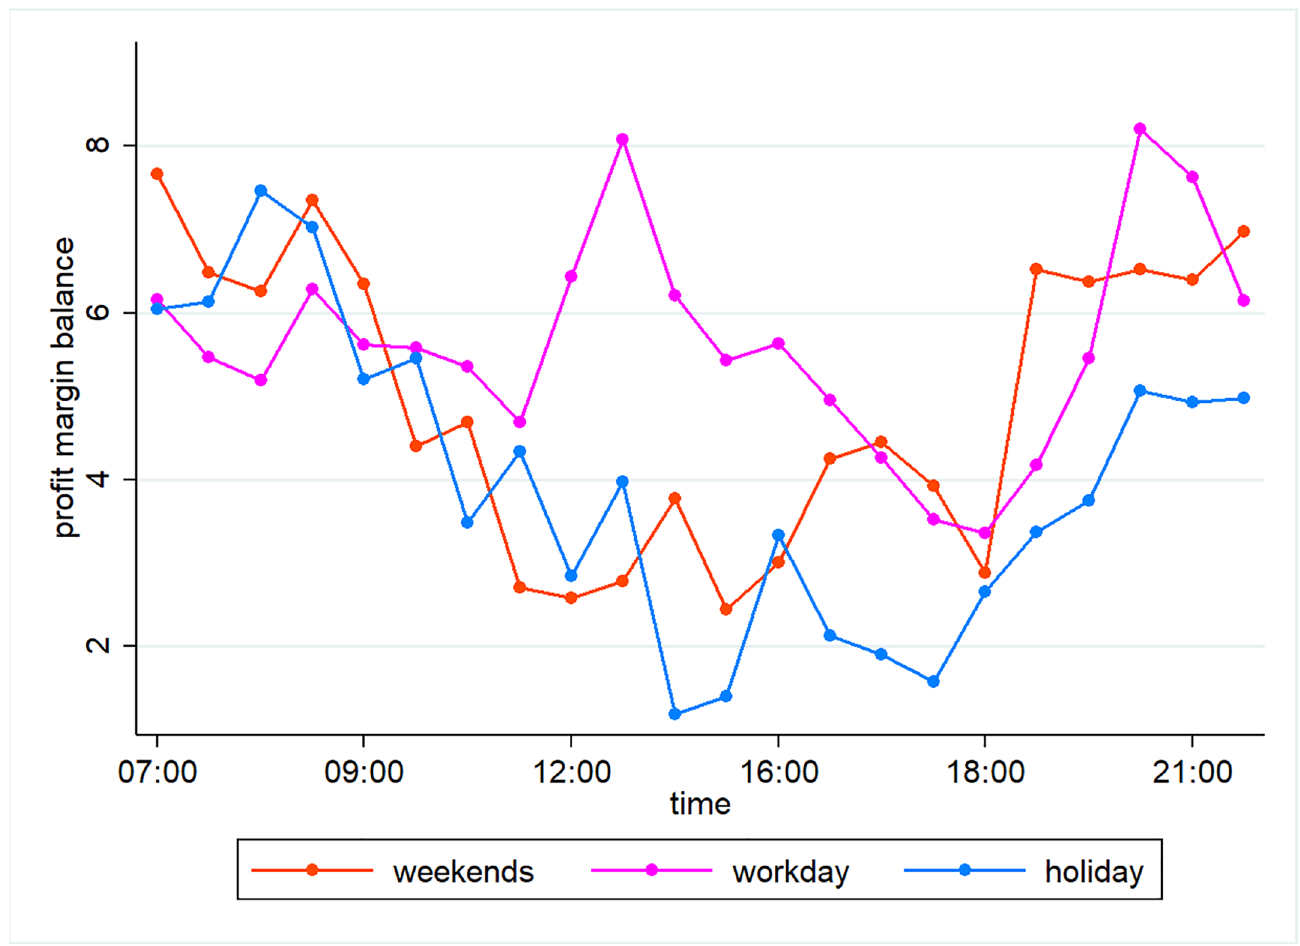
Fig 5. The changes in profit margins’ difference over time on congested and non-congested